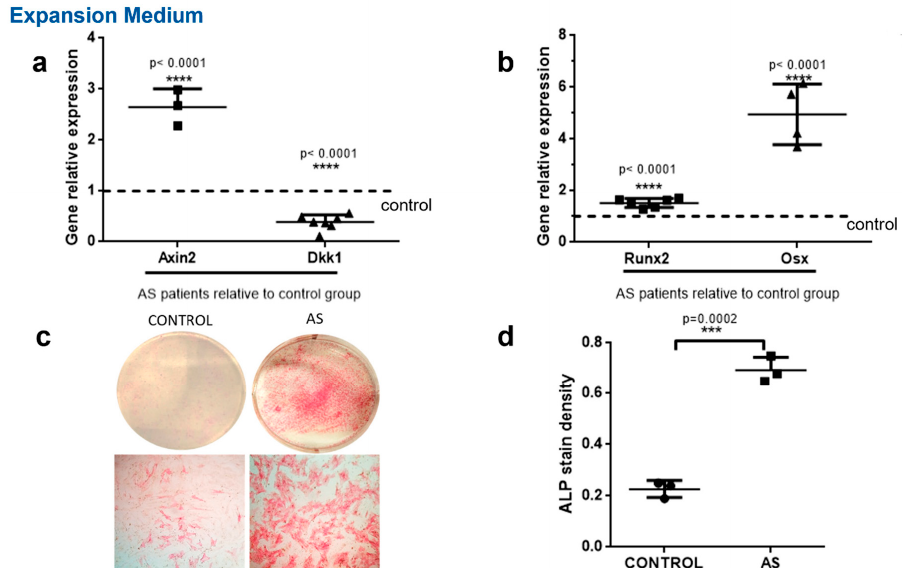
Figure 1. Decreased DKK1 expression and increased WNT pathway activity in MSCs from AS patients. MSCs from the control group and the AS group were cultured in vitro in expansion medium. ( a , b ) Axin2, Dkk1, Runx2 and Osx expression levels were determined with the quantitative RT-PCR method. Each gene’s expression is presented as a fold expression in AS cells relative to the control group expression normalized to unity. ( c , d ) ALP activity in cultured cells. ( c ) Macroscopic images of the culture dishes (top row) and representative microscope images (bottom row). ( d ) Scatter plots depicting the quantification of ALP stain density. Data are presented as mean ± SD. *** = p < 0.001; **** = p < 0.0001. We next assessed whether increased Wnt pathway activation in AS MSC coincided with increased osteoblastic activity by evaluating the expression of the key osteoblastic genes, Runx2 and Osx, and ALP activity. Both Runx2 and Osx were upregulated in AS compared to control MSCs ( p < 0.0001 for both Runx2 and Osx, Figure 1b). Moreover, AS MSCs presented with increased ALP activity compared to controls ( p = 0.0002, Figure 1c,d). Similar results were obtained when we analyzed MSCs committed to the osteoblastic lineage following culture in osteogenic medium. Osteoblasts from patients with AS exhib- ited significantly lower DKK-1 gene expression ( p < 0.0001) and remarkably higher Axin2 expression ( p = 0.0032) compared to controls (Figure 2a).